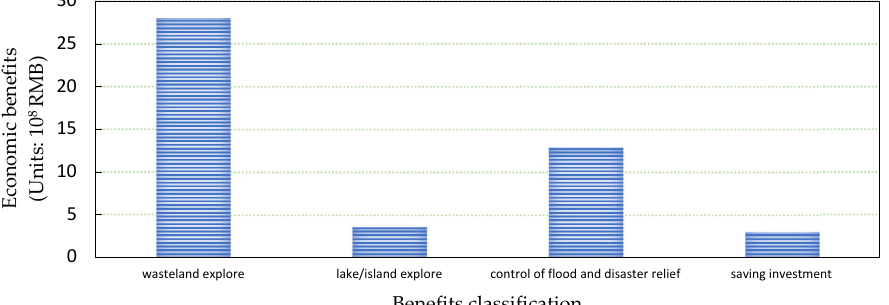
Figure 19. The economic benefits of the comprehensive treatment project.